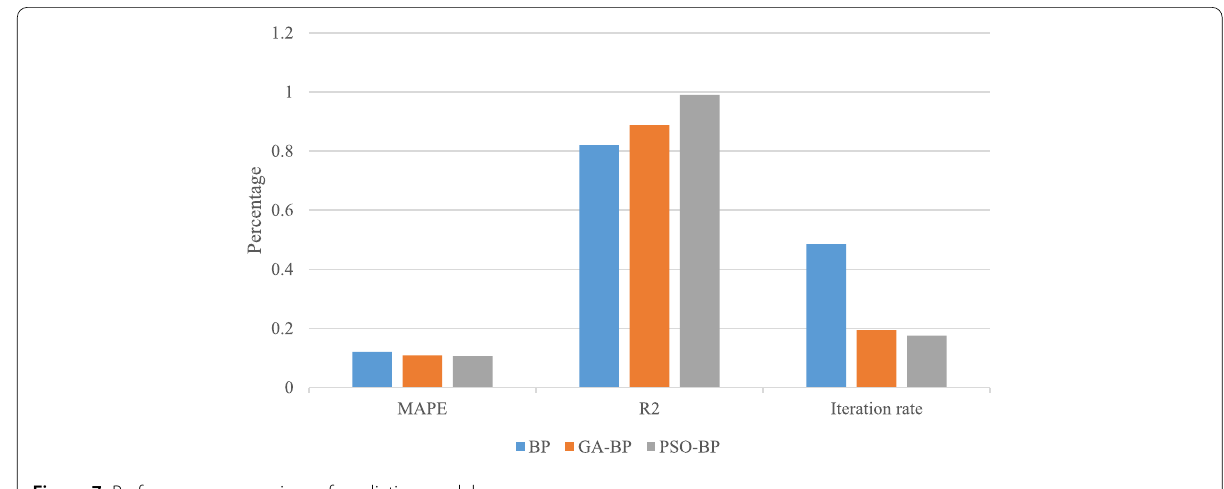
Figure 7 Performance comparison of prediction models